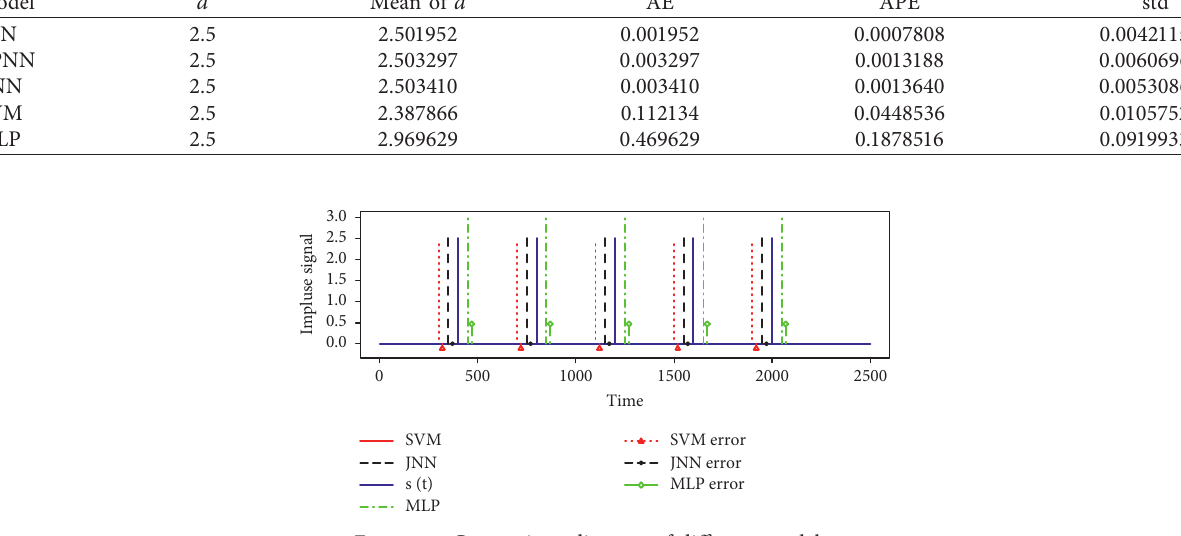
Figure 5: Comparison diagram of different models.